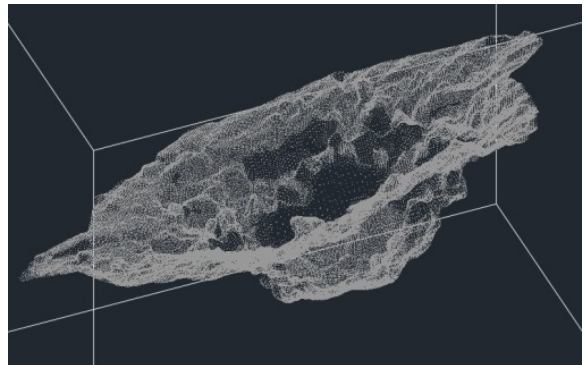
Figure 4. Picture of crater surface in AutoCAD Civil 3D using point